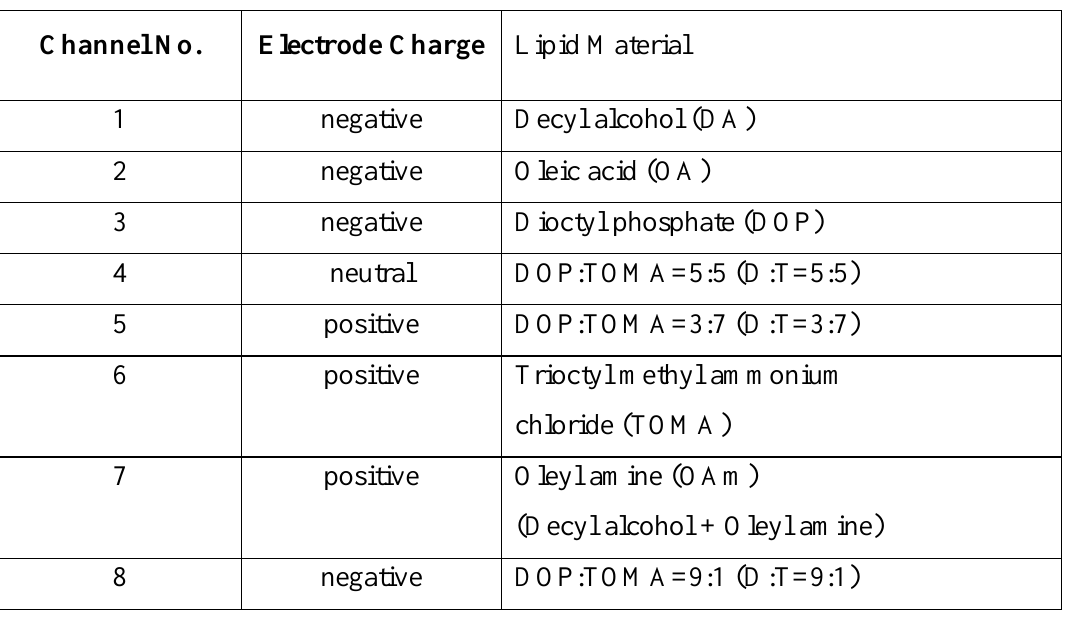
Table 1. Lipid materials used for membrane